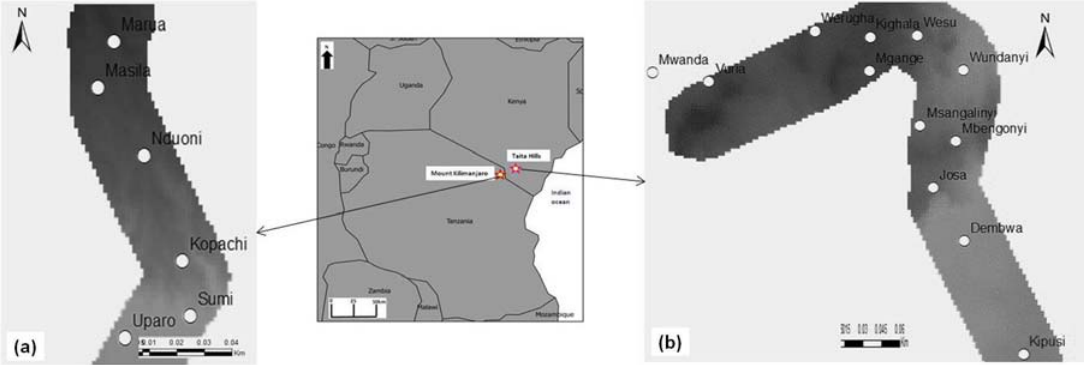
Figure 1. Location of study areas along the southeastern slopes of Mount Kilimanjaro in northeastern Tanzania and the Taita Hills in southeastern Kenya. White circles are sampling blocks along each study transect. ( a ) Mount Kilimanjaro; ( b ) Taita Hills.